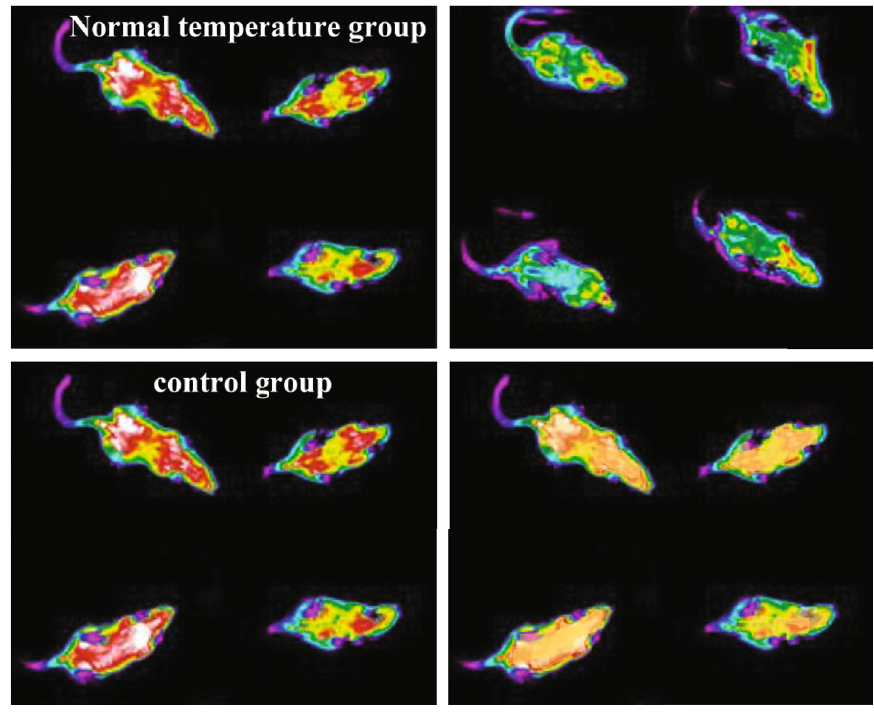
Figure 8: Infrared imaging of body temperature of experimental animals.